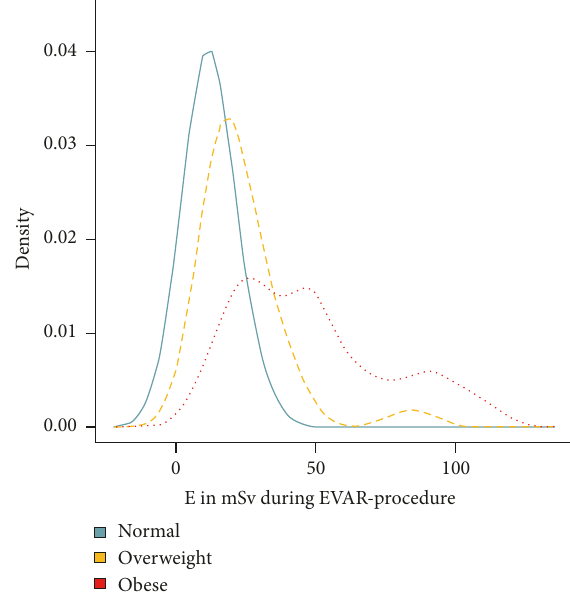
Figure 6: Density curves for the ED delivered to the three WHO BMI categories during